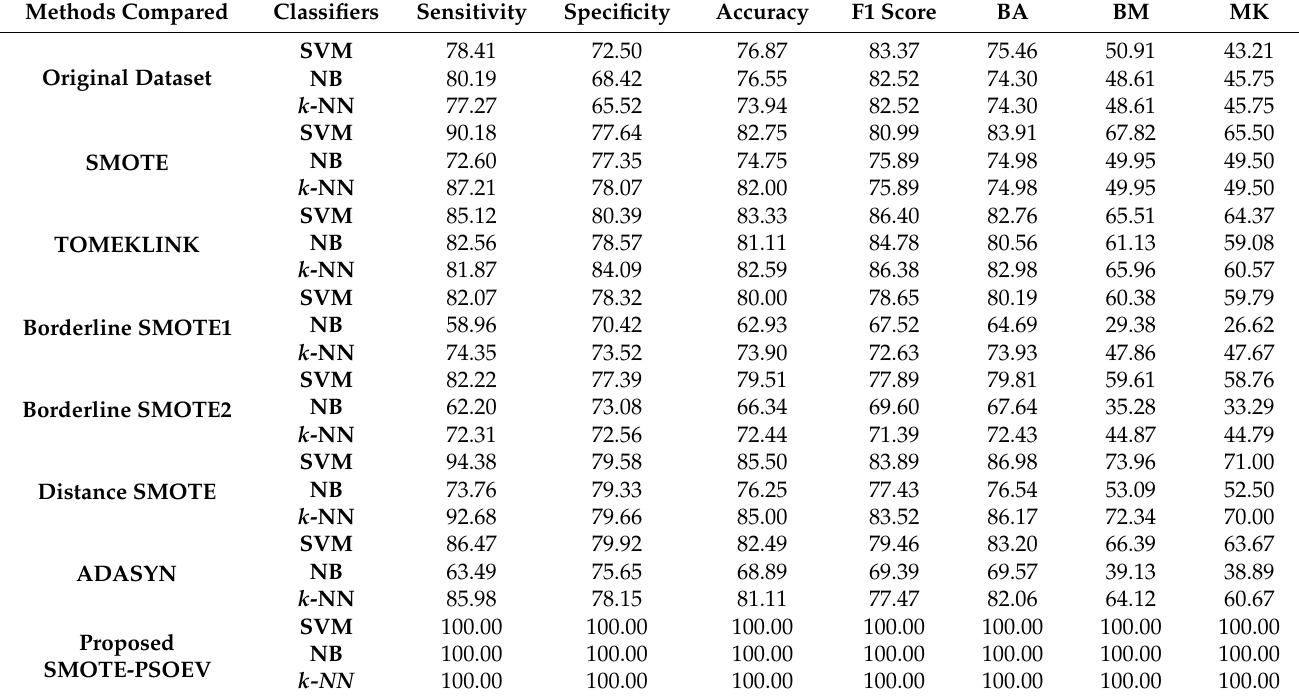
Table 3. Performance recognition (in %) of Pima dataset.